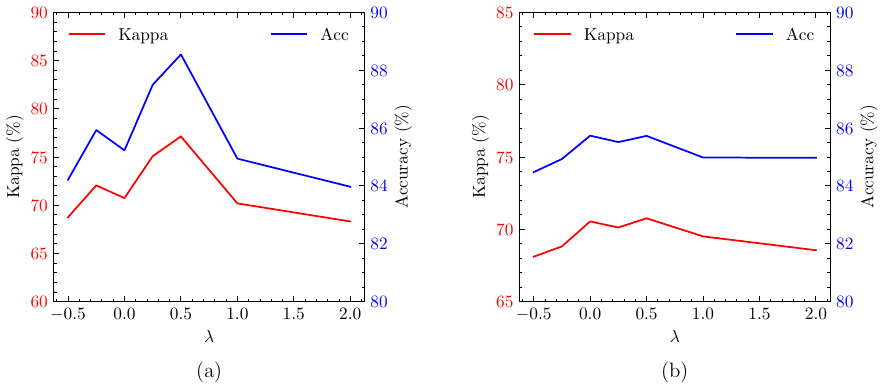
Figure 10. The influence of parameter λ on the Bay Area dataset and the Santa Barbara dataset. ( a ) The influence of λ on the Bay Area dataset. ( b ) The influence of λ on the Santa Barbara dataset. We also compared the curves of the training loss and accuracy of the network with lambda of 0.5, 1, and 2, respectively. As shown in Figure 11, for the λ parameter of 0.5 (the optimal parameter), the network converges to a better position at 10,000 iterations, which is faster compared to the other sample sets.